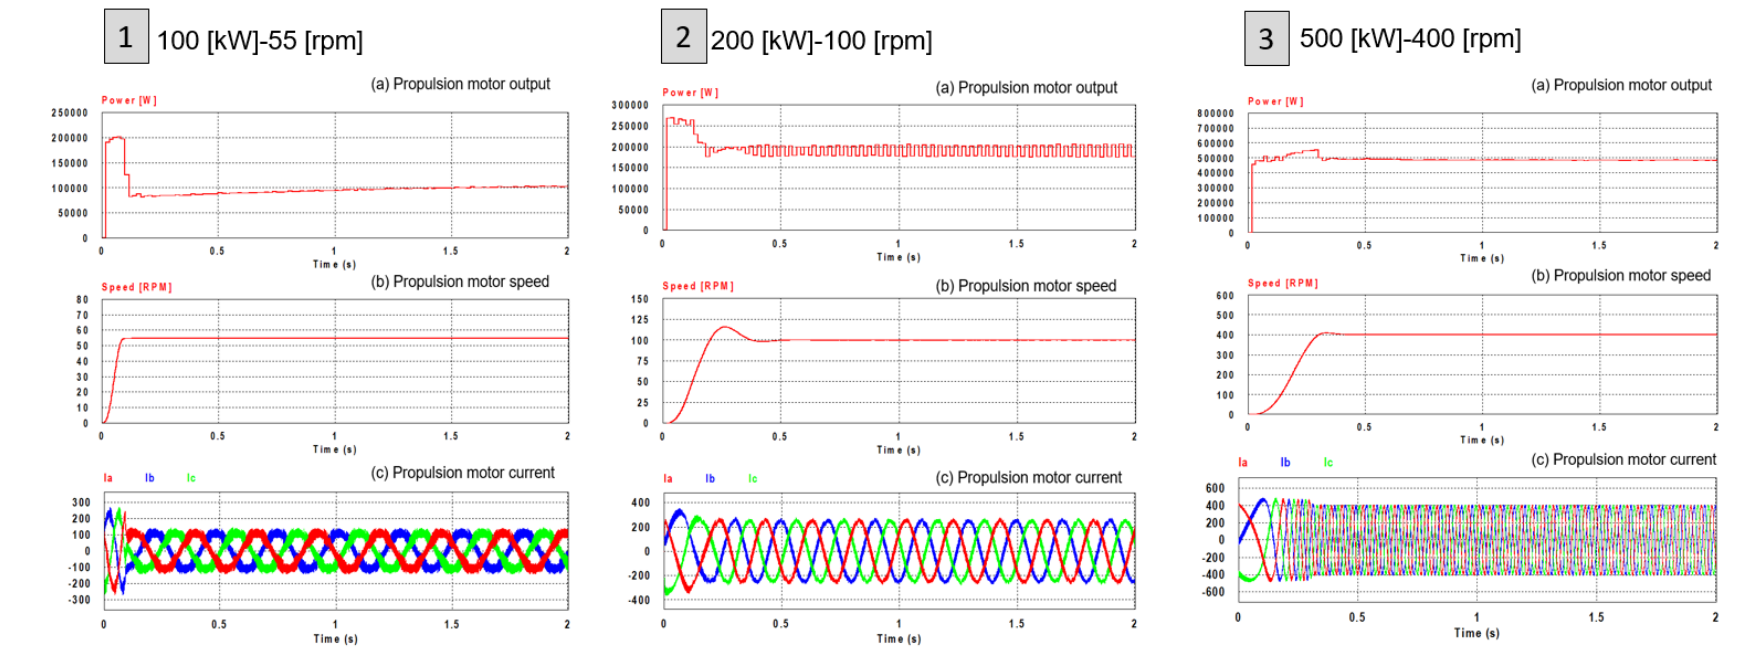
Figure A5. Simulation results of battery electric propulsion; (1) at 100 kW-55 rpm, (2) at 200 kW-100rpm, (3) 500 kW-400 rpm phases.